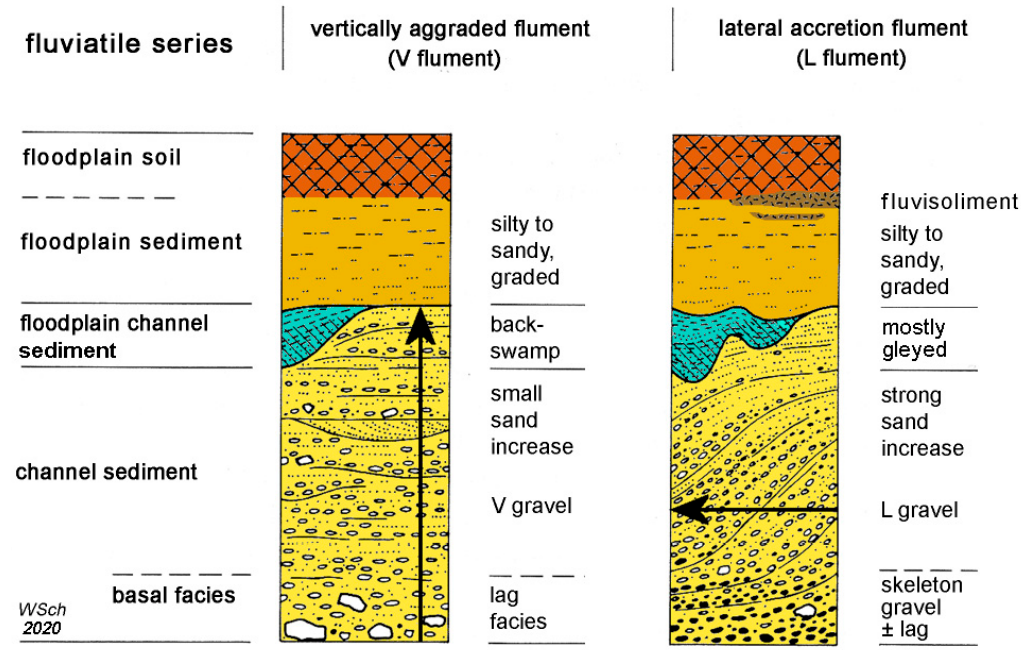
Figure 2. Flument structures. A complete flument is composed of all members of the fluviatile series. The skeleton gravel is marked by black pebbles in all figures of this paper.